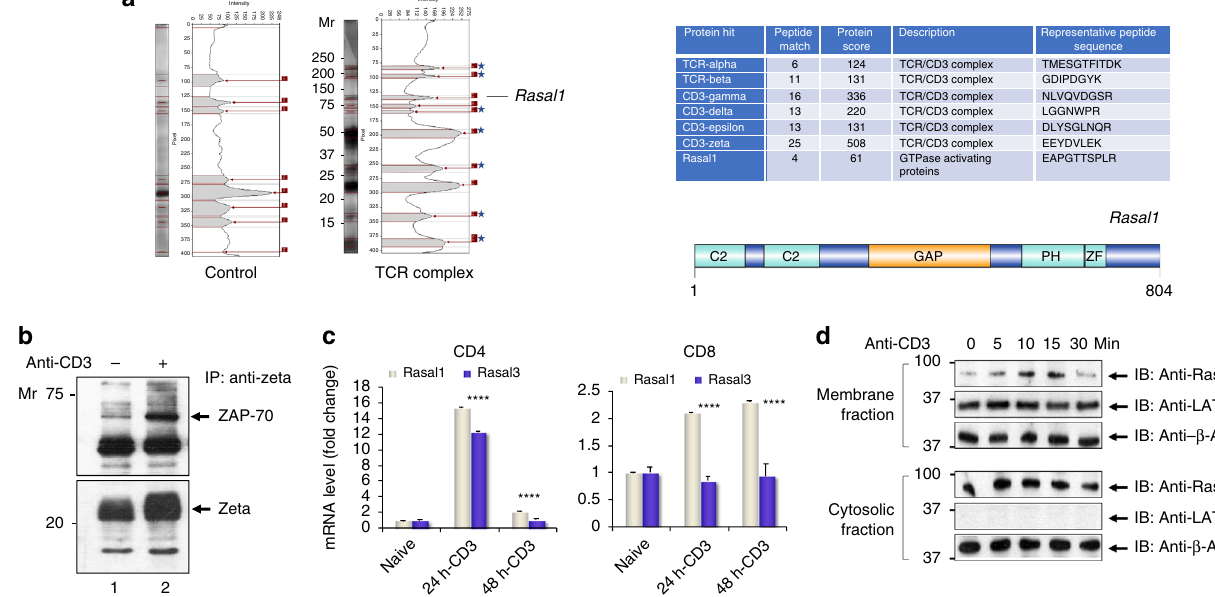
Fig. 1 TCR complex puri fi cation and Rasal1 association with ZAP-70 in the TCR complex. a Analytic gel from tandem af fi nity puri fi cation (TAP) of TCR plus associated proteins captured from TCR-constituted cells (TCR complex) versus TCR-null negative control cells (control) (left panel). Chart showing the list of TCR-associated proteins identi fi ed by MS analysis (right upper panel). The structure of Rasal1 (right lower panel). b Co-precipitation of ZAP-70 with TCR from 3A9 T cells. 3A9 cells were stimulated for 10 min with anti-CD3 followed by immunoprecipitation with anti-TCR zeta and blotting with anti-ZAP- 70 or anti-zeta. Lane 1: resting T cells; lane 2: anti-CD3-stimulated T cells. c Rasal1 expression is induced with anti-CD3 activation. Relative fold change expression of Rasal1 versus Rasal3 upon anti-CD3 stimulation of CD4 + and CD8 + peripheral T cells. 18 s rRNA served as a control. d Anti-CD3 induces Rasal1 translocation to the membranes of T cells. Stimulation-dependent association of Rasal1 with the membrane (upper panel) versus cytosolic Rasal1 (lower panel). Anti-actin served as a loading control. LAT was used as a marker of membrane enrichment fractionation ( n = 3)